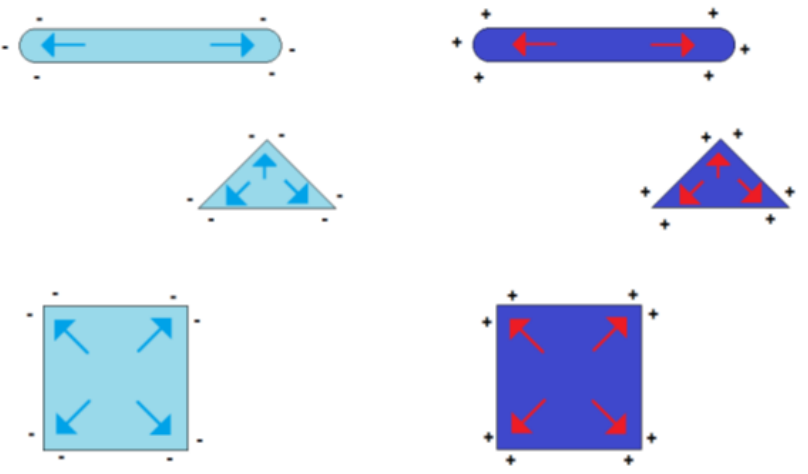
Figure 3. Formation of charge centers of gravity in the case of electrically charged nonspherical metal nanoparticles (blue symbolizing negative excess charge, red symbolizing positive excess charge)